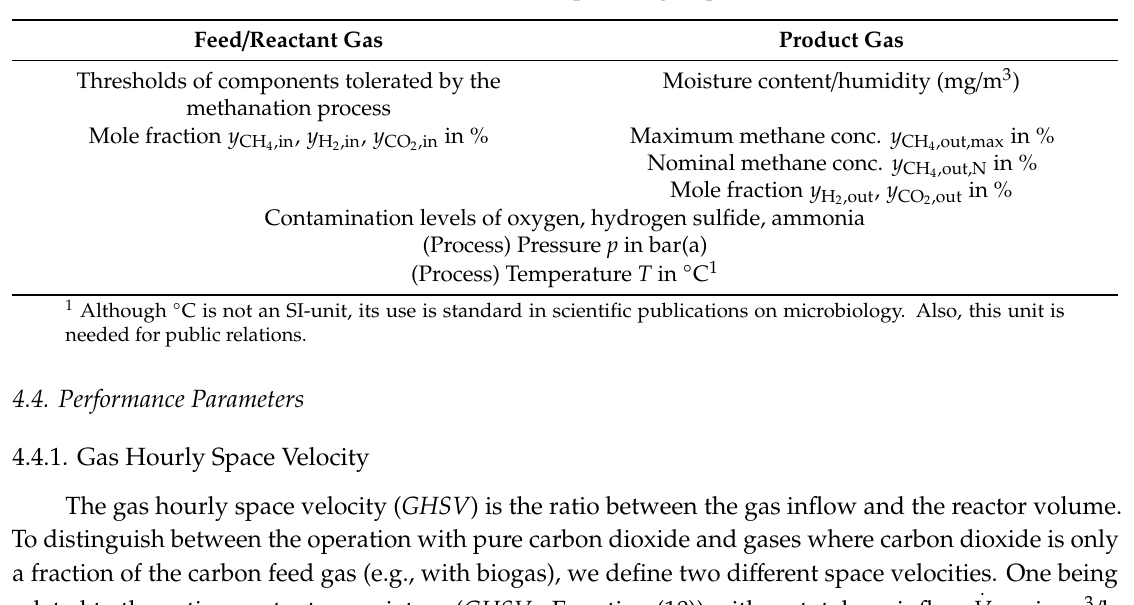
Table 6. Recommendation on feed and product gas specifications to